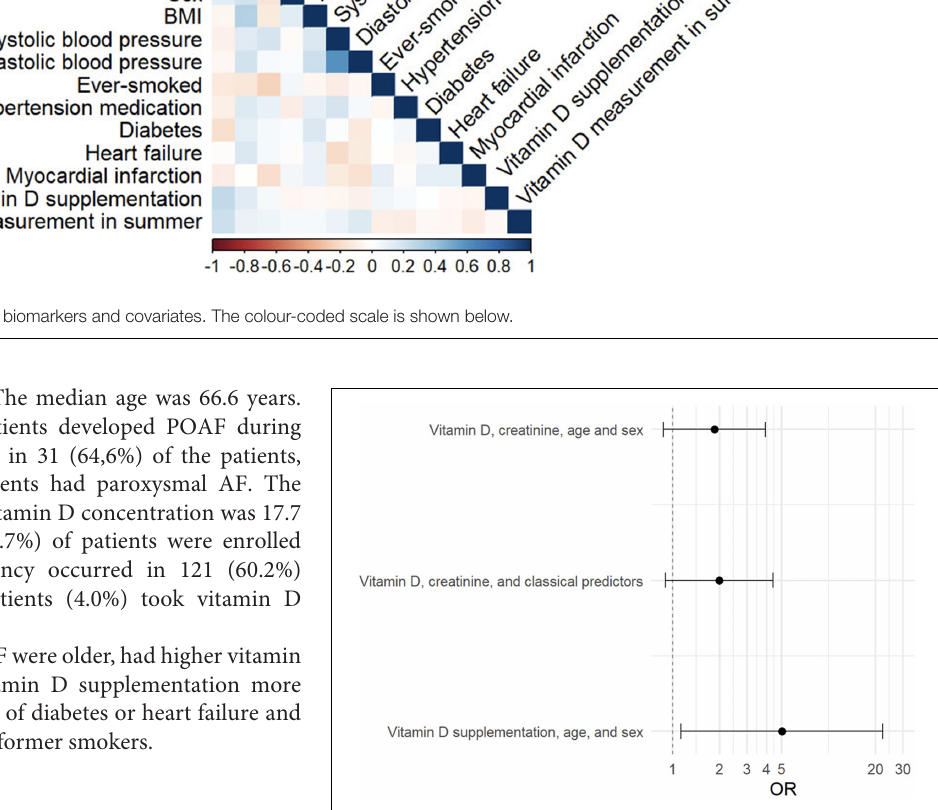
FIGURE 2 | OR-plot showing the odds ratios and 95% confidence intervals for the logistic regression